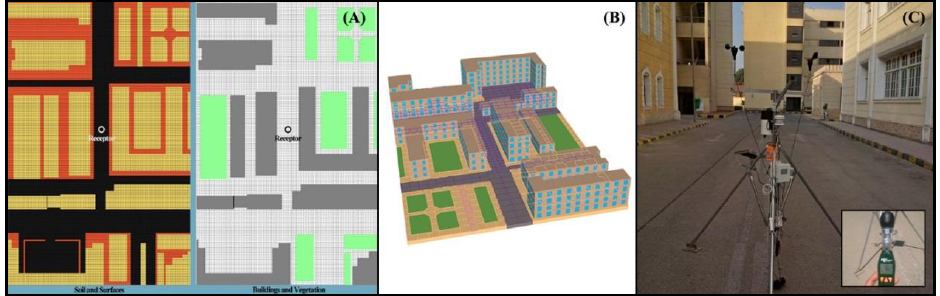
Figure 5. Model area: ( a ) in ENVI-met; ( b ) from Grasshopper/Rhino 3D; and ( c ) during field measurements.